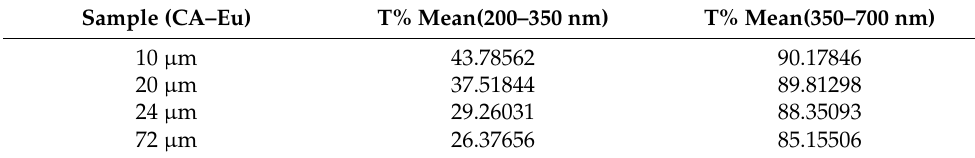
Figure 7. UV-visible transmittance spectra of CA, CA–Eu and CA–Eu–Tb films. ( a ) the transmittance spectra, ( b ) the transmittance spectra of CA–Eu film of different thicknesses. Table 2. Mean of light-conversion film (CA–Eu) of different thicknesses for